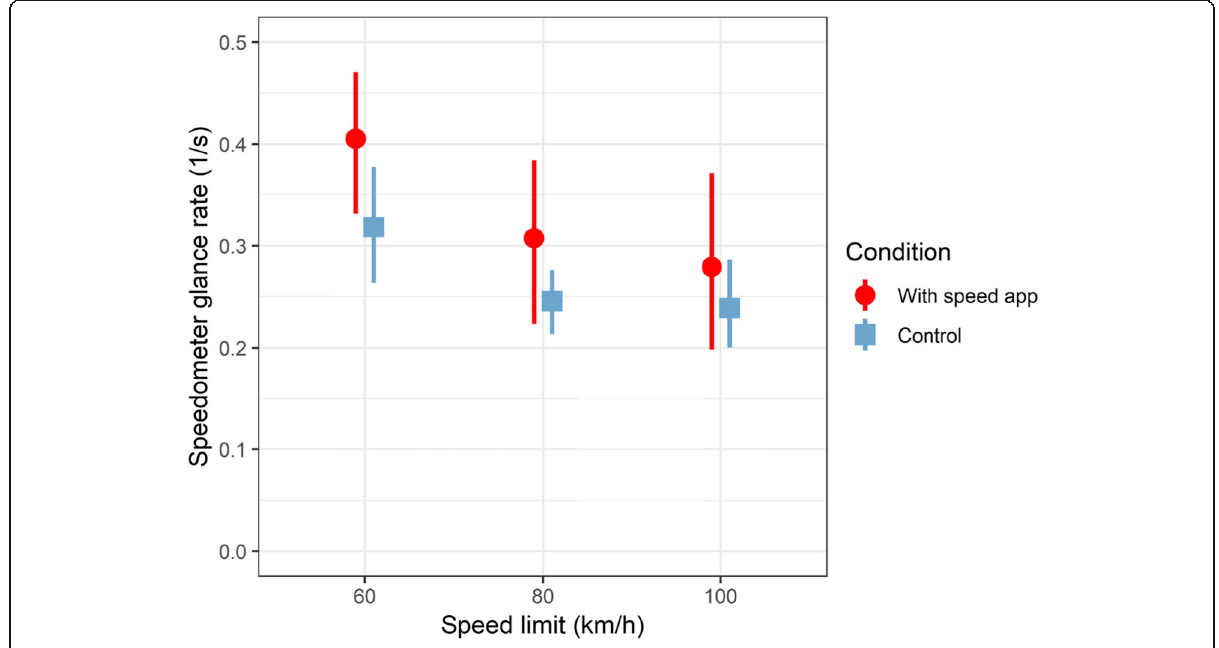
Fig. 4 Speedometer glance rate as a function of the speed limit and group (with speed app vs. control). Means and 95% CI